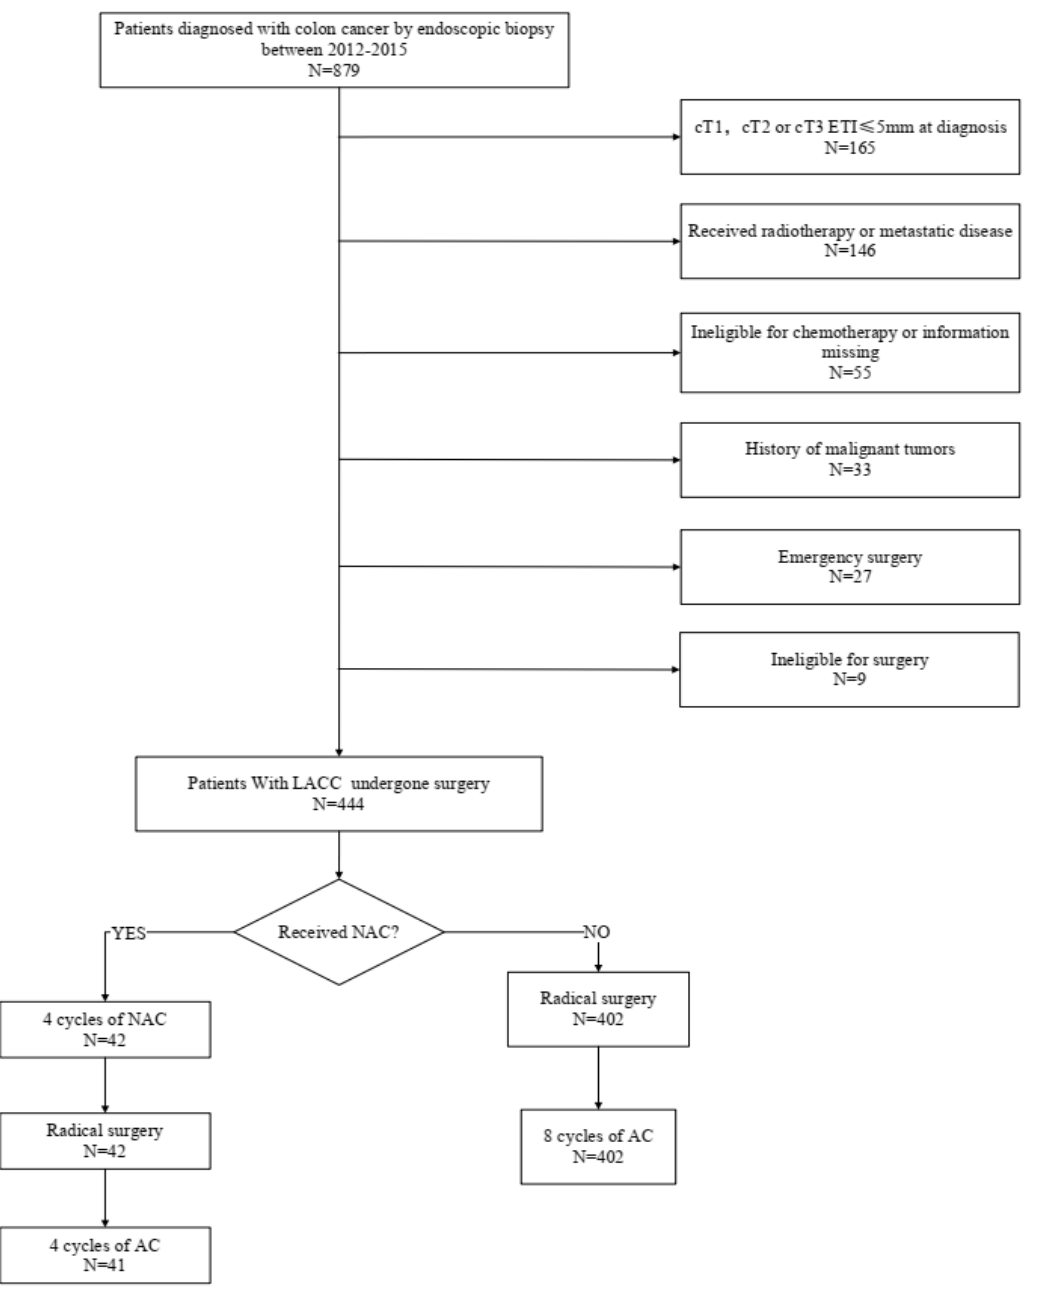
Figure 1. Flowchart of patient